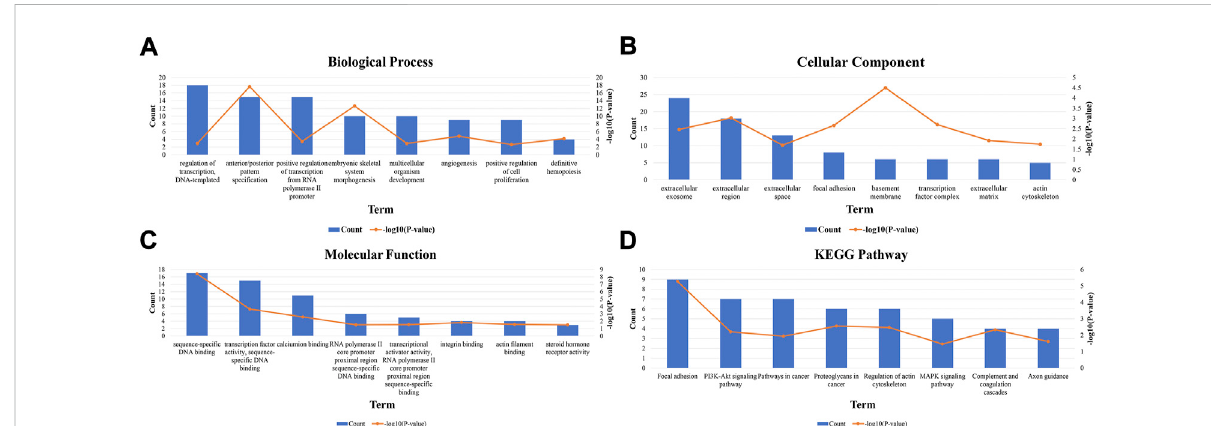
FIGURE 9 GOtermsandtheKEGGpathway. (A) GOenrichmentoftargetgenesinbiologicalprocessontolagy( p < 0.05). (B) GOenichmentoftargetgenes in cellular component ontology ( p < 0.05). (C) GO enrichment of target genes in molecular function ontology ( p < 0.05). (D) The top 8 pathways related to the differentially expressed genes by the KEGG database analysis. BP, biological process; CC, cellular component GO, gene ontology analysis; KEGG, Kyoto Encyclopedia of Genes and Genomes; MF, molecular function.